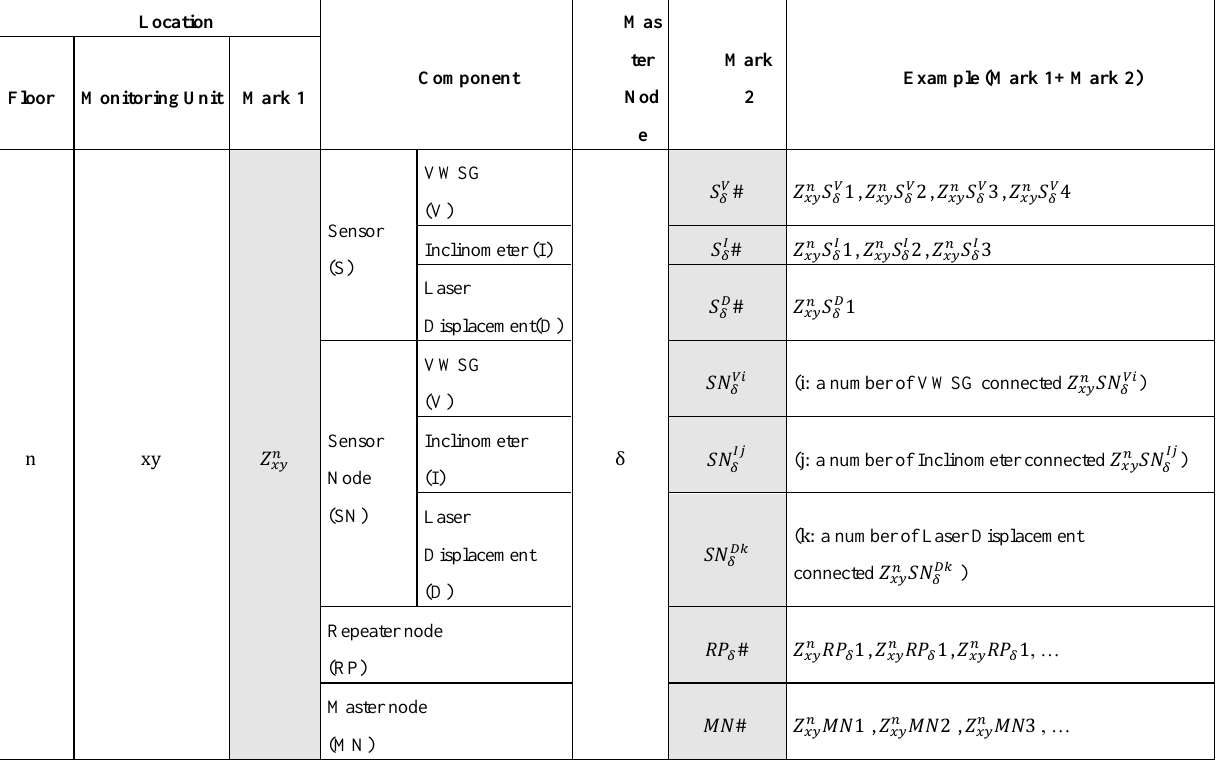
Table 1. Notation